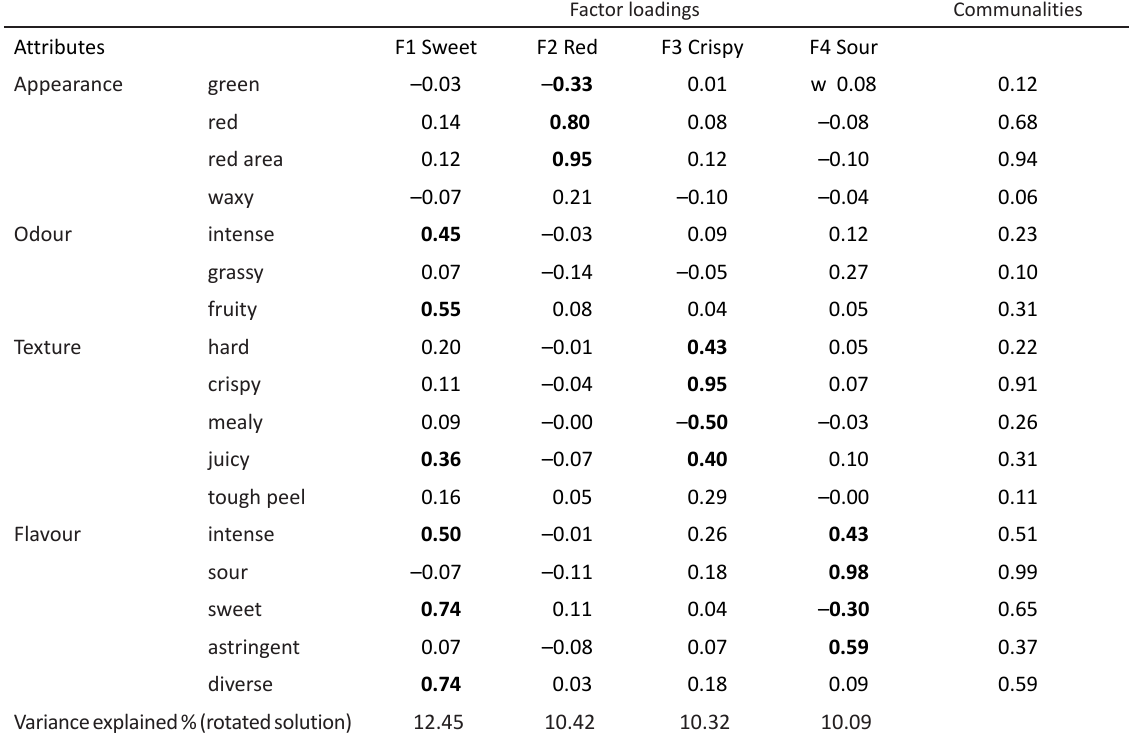
Table 5. Factor loadings (F1–F4) and communalities of the attributes evaluated in harvest years 2009–2011. Loadings of ±0.3 or stronger are marked with